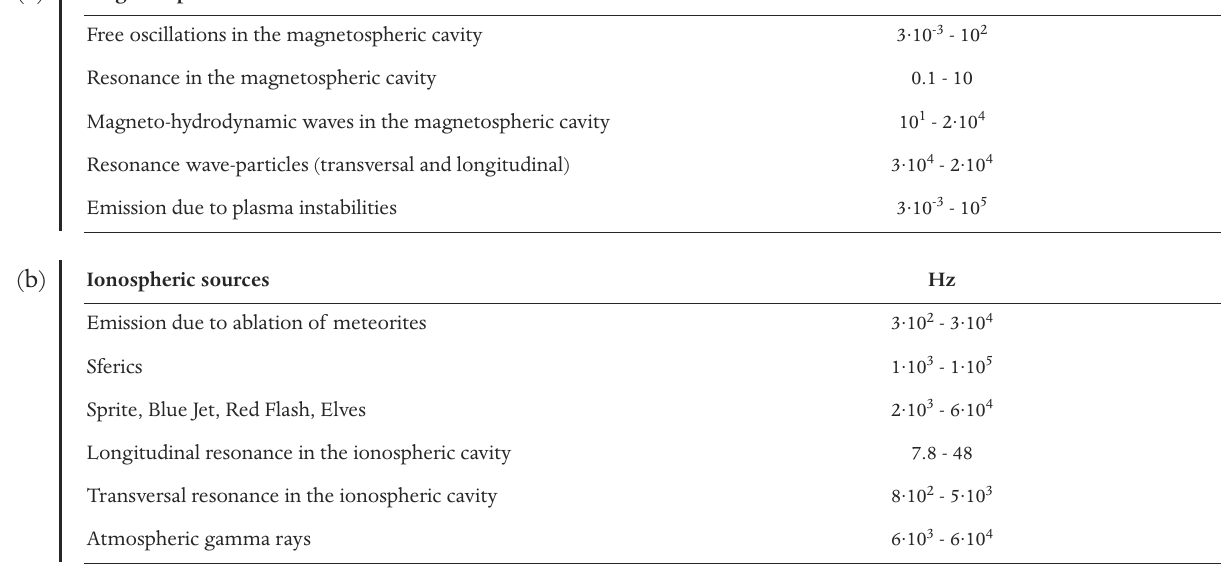
Table 3. (a) Magnetospheric and (b) ionospheric EM